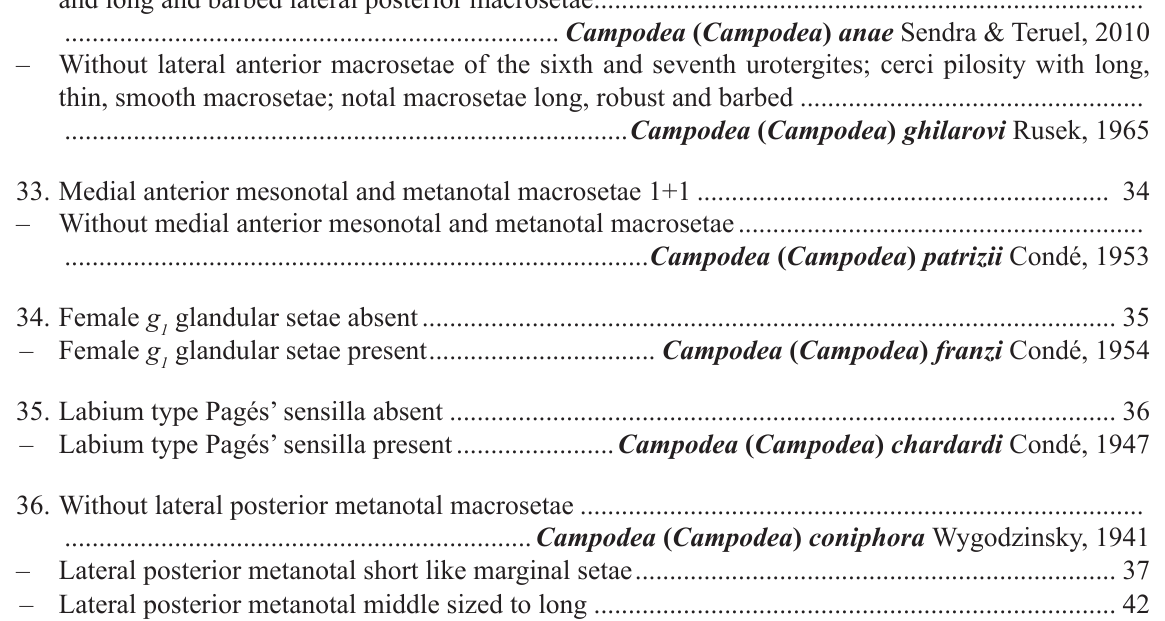
Lateral posterior metanotal long to middle sized; lateral posterior mesonotal large to middle sized; cerci pilosity with long, barbed macrosetae and a few short smooth setae ..................................... 27 27. Medial anterior macrosetae of the ninth urotergite 1+1; marginal setae short thick with a